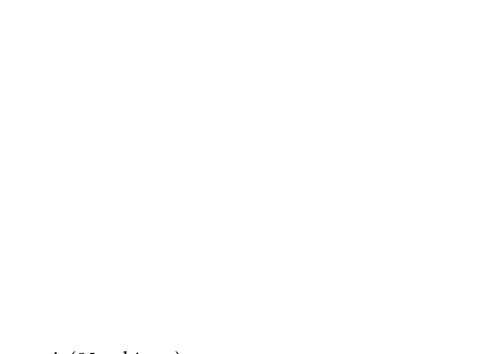
Table 1. Total number of synthesized images from dataset A (93